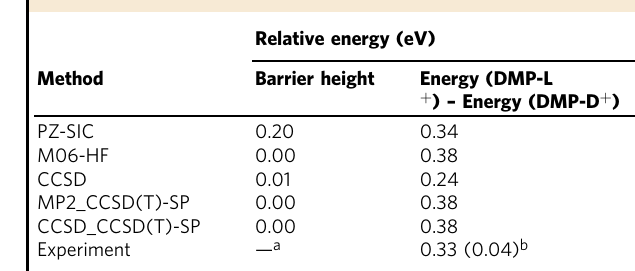
Table 1 Relative energies of the DMP-L + and DMP-D + states obtained from various computational